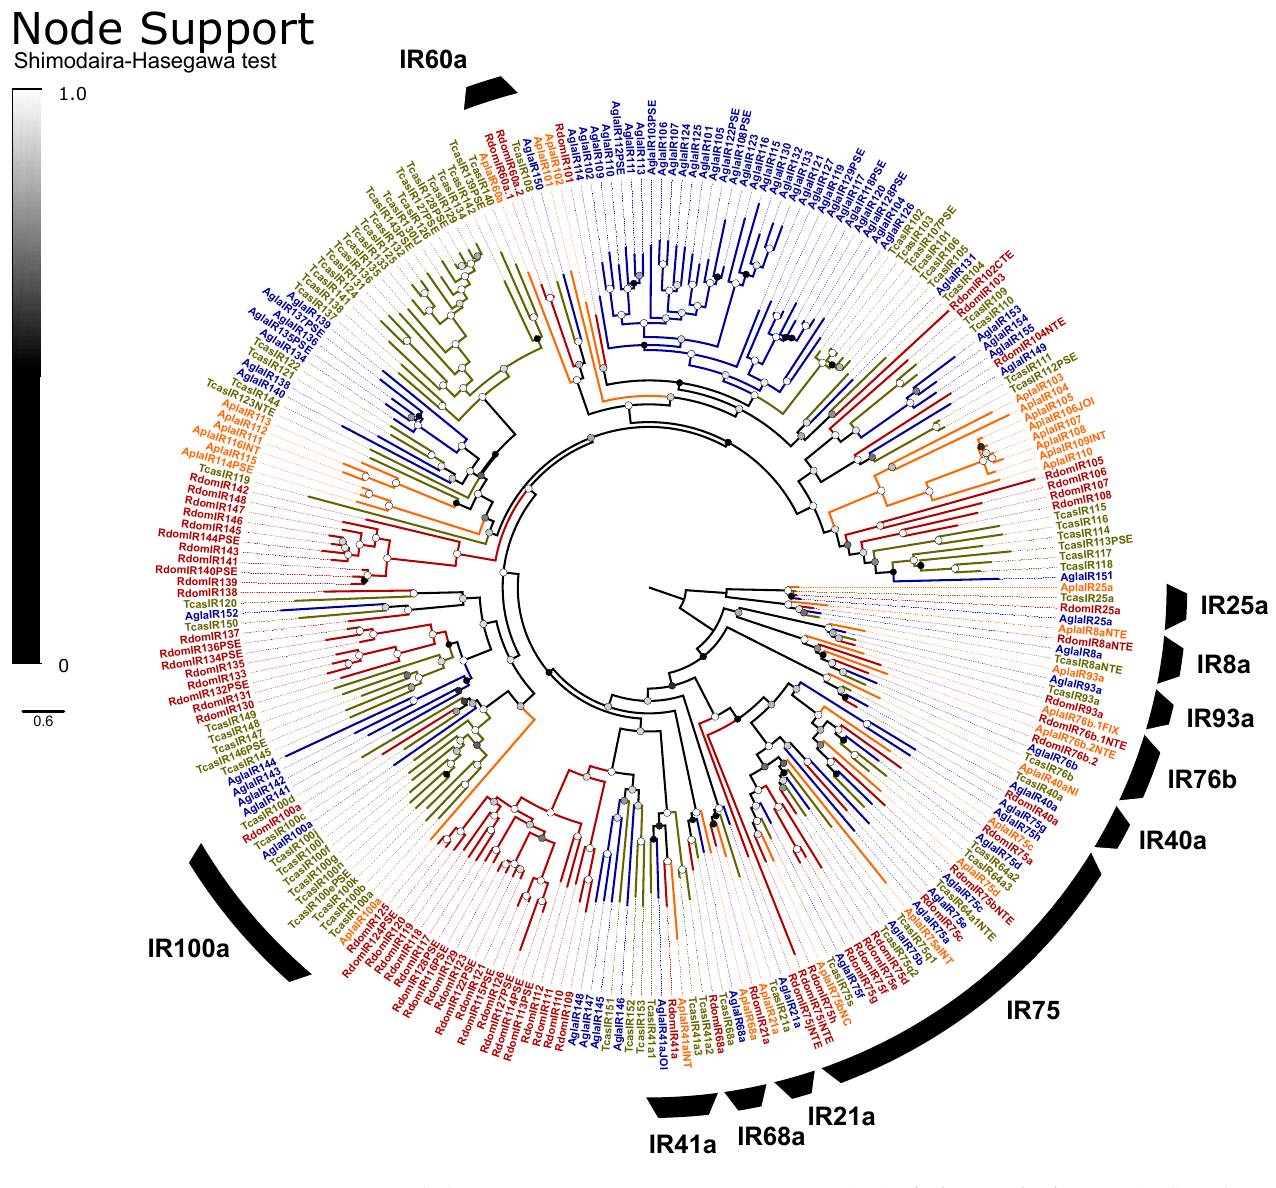
Figure 5. Phylogeny comparing ionotropic receptors (IRs) of Rhyzopertha dominica (red) to those of Anoplophora glabripennis (blue), Tribolium castaneum (yellow), and Agrilus planipennis (orange), rooted with the conserved co-receptors IR8a and IR25a. Colored circles at nodes represent Shimodaira–Hasegawa support values, shaded from black (0–0.5) to white (1.0). Black arcs describe the coleopteran lineages of conserved antennal IRs, named by their ortholog in Drosophila melanogaster (bottom right). Unlabeled IRs and the conserved monophyletic lineages IR100a (left) and IR60a (top) are classified as divergent IRs.